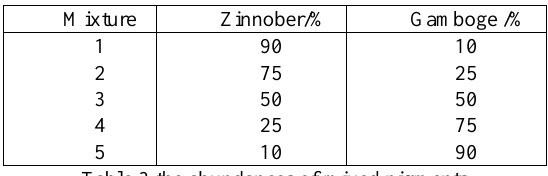
Figure.5 ROIs in the ancient